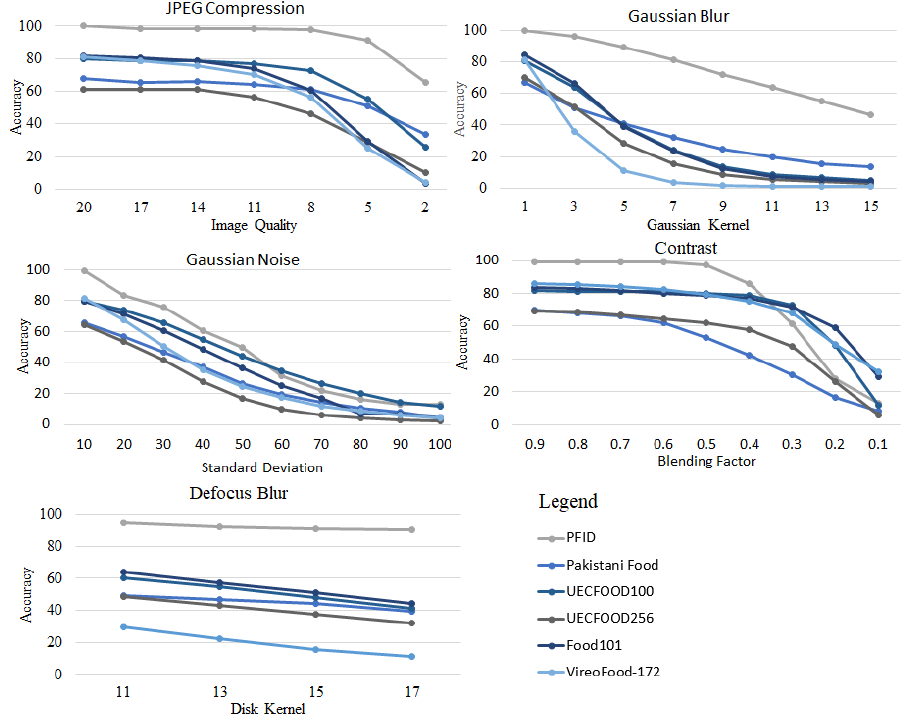
Figure 10. InceptionResNetV2 under various quality distortions in the image: JPEG compression, Gaussian blur, Gaussian noise, and defocus